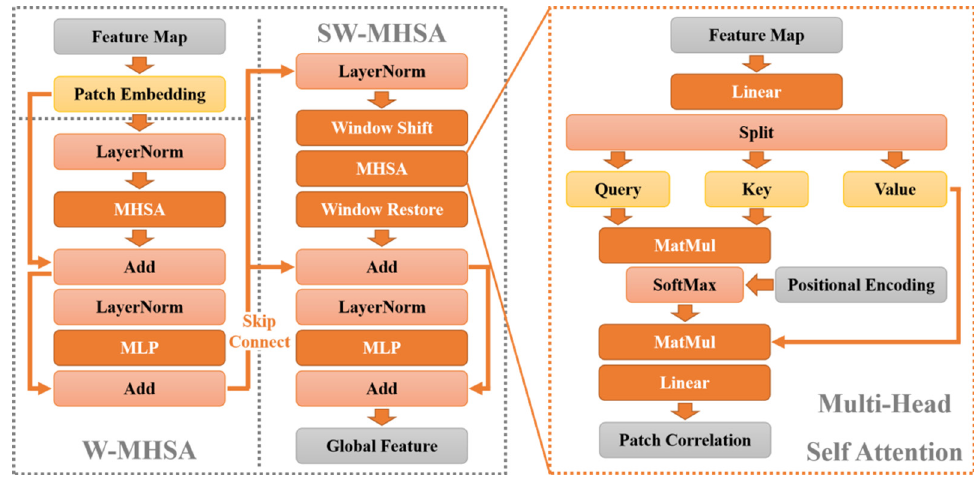
Figure 10. Structure of the Swin A tt ention Block.